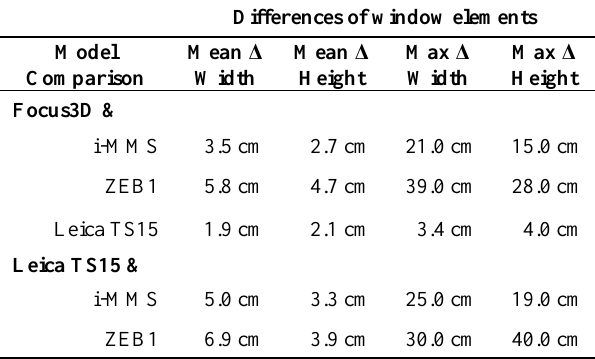
Table 4: Differences based on 7 window elements